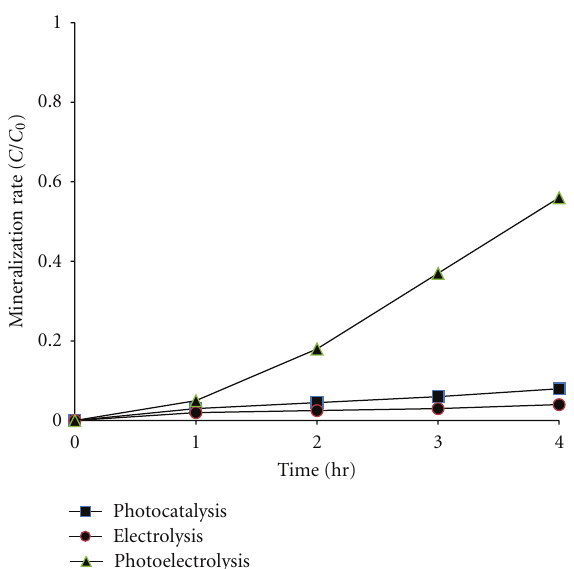
Figure 5: Mineralization rates of sodium oxalate under the di ff erent reactions at pH 4.